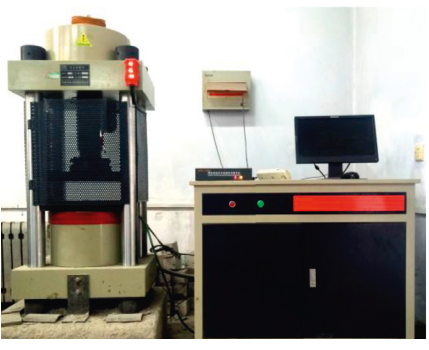
Figure 4: Test setup.